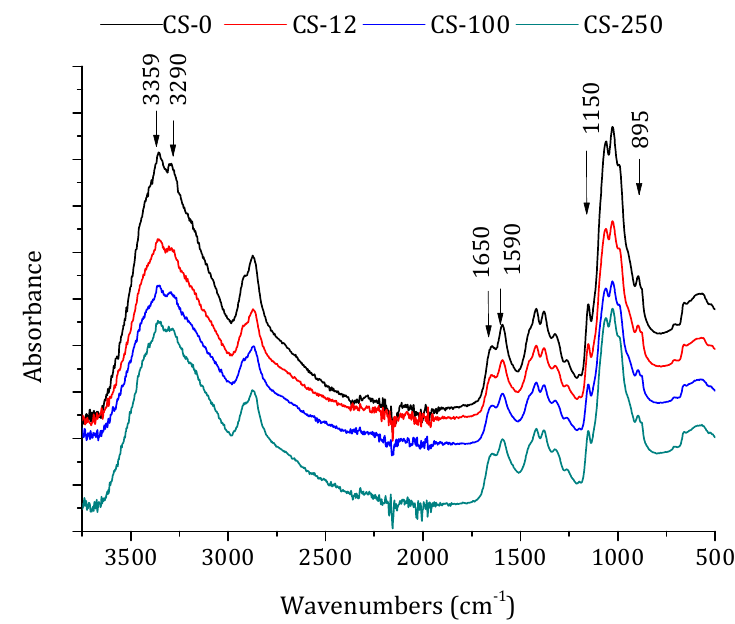
Figure 3. FTIR-ATR spectra of chitosan powders: non-irradiated (CS-0) and irradiated at different doses in solid state, 12.5 kGy (CS-12), 100 kGy (CS-100), and 250 kGy (CS-250).